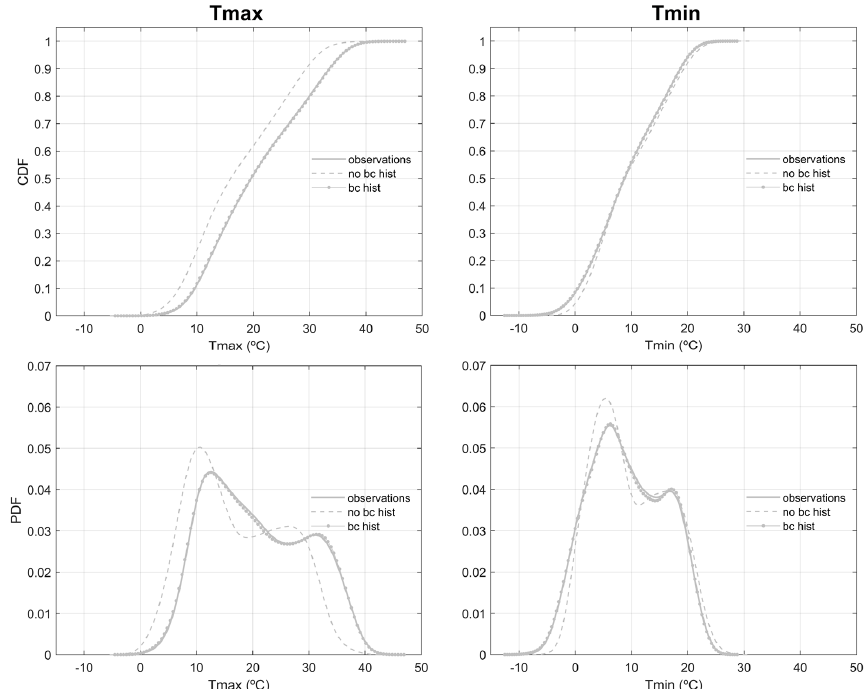
Figure 5. Cumulative distribution function (first row) and probability density function (PDF, second row) of the simulations with no bias correction of the historical period (no bc hist), observations and bias correction of the historical period (bc hist) for the daily maximum and minimum temperature (Tmax and Tmin, °C) (first and second column, respectively) for Madrid.